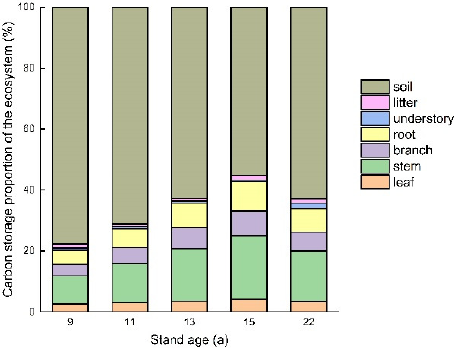
Figure 6. Carbon storage proportion of the ecosystem from leaf, stem, branch, root, understory and litter in the 9-, 11-, 13-, 15-, and 22-year-old T . Zhongshanshan